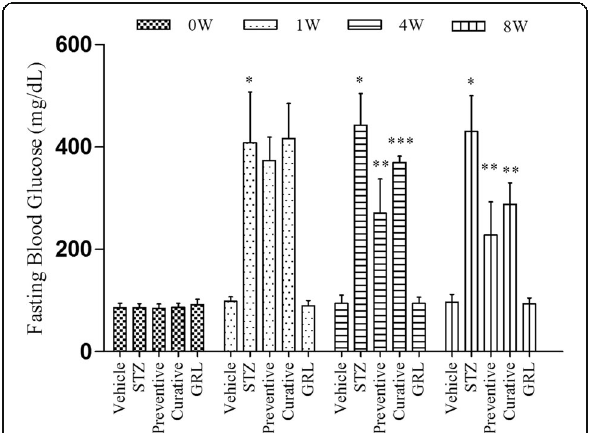
Fig. 1 Effects of GRL on fasting blood glucose (FBS). Histogram shows the levels of FBS in all groups. Values are expressed as milligrams per deciliter (mg/dL) of 7 rats/group. * P < 0.001 versus vehicle group and GRL group; **P < 0.001 versus STZ group; *** P < 0.05 versus Preventive group by one-way ANOVA followed by Tukey ′ s post-hoc tests